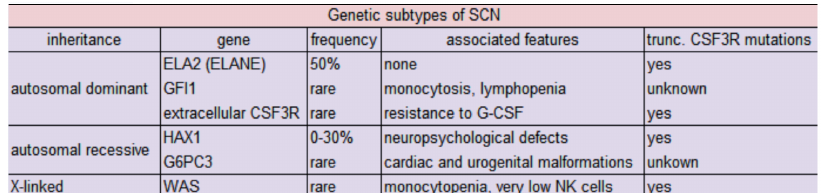
Table 1. Genetic subtypes of